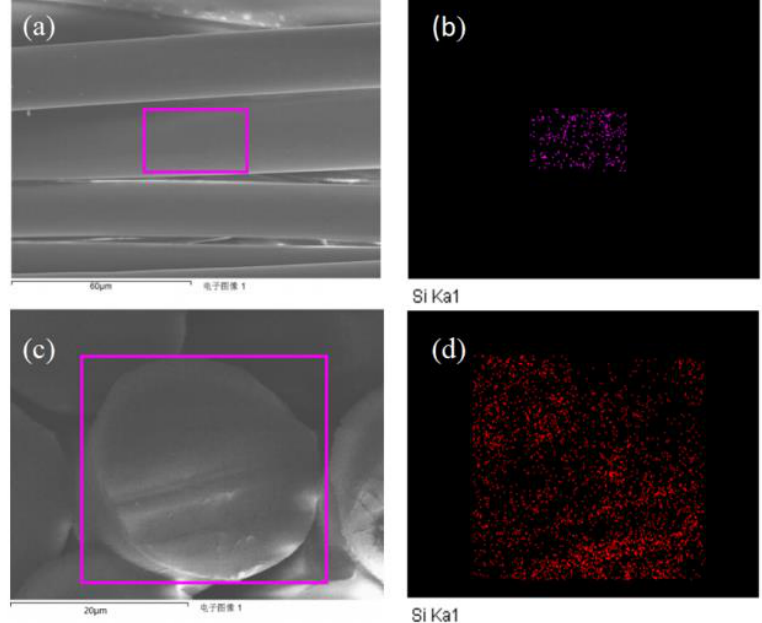
Figure 4. Electron scanning micrograph ( a , c ) and element mapping of surface and cross section of PA66 / 3%PDMS blend fiber ( b , d ). Table 2. Surface friction coe ffi cient of the obtained fibers.